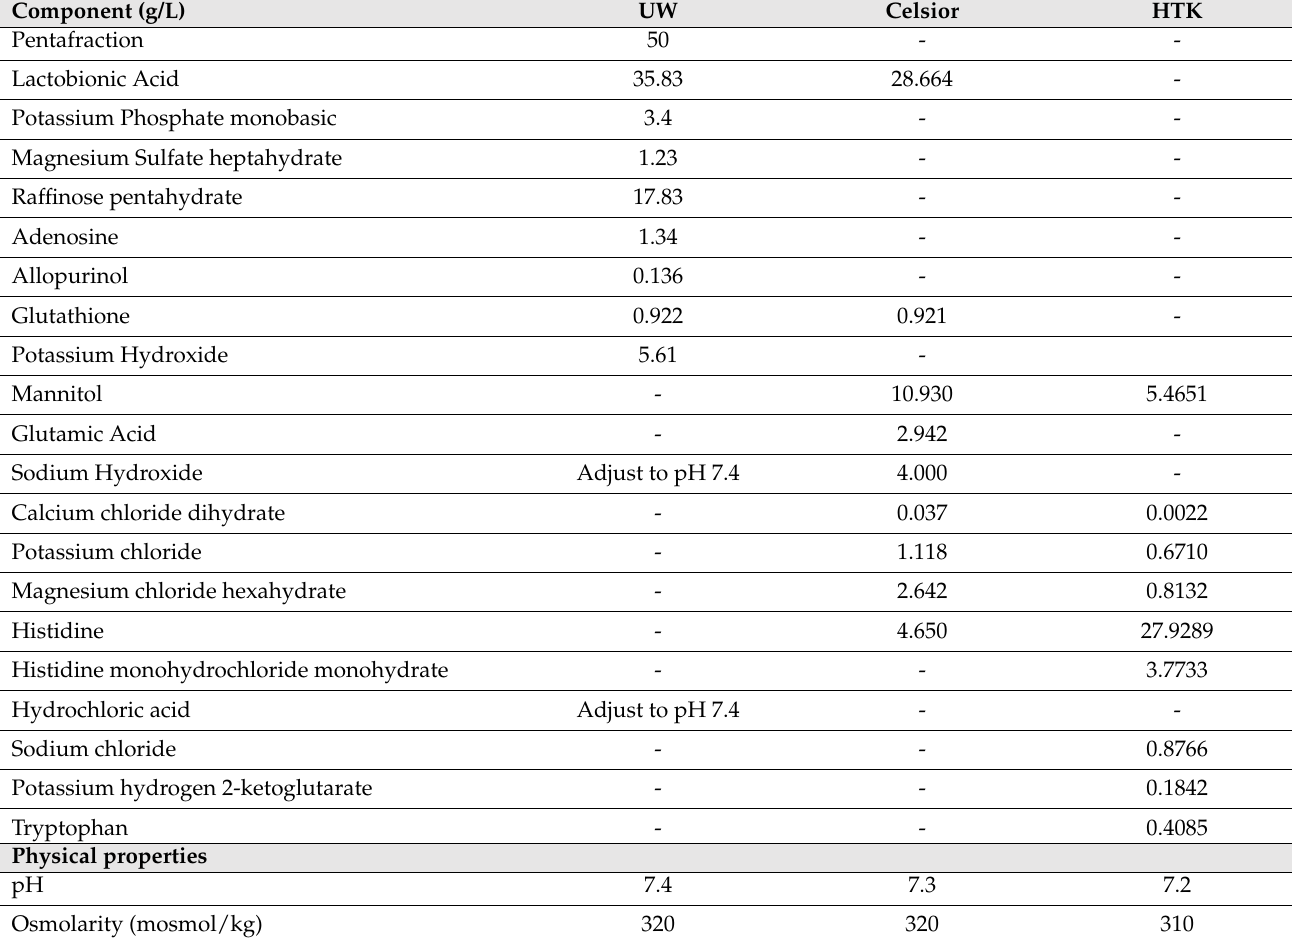
Table 1. Components and properties of commonly used heart preservation